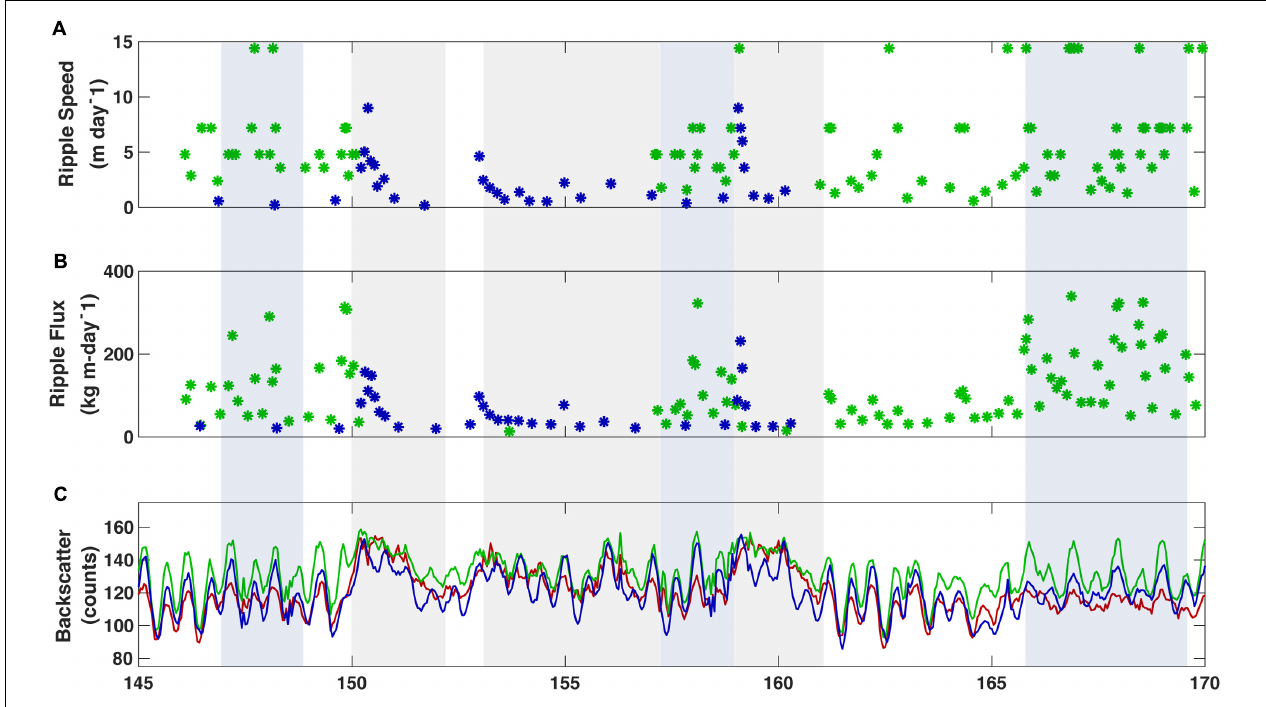
FIGURE 7 | Sediment flux parameters measured at the three sites across the reef flat and lagoon. (A) Bedform migration rate. (B) Total sediment flux by migrating bedform. (C) Near-bed acoustic backscatter from 10 cm above bottom, a proxy for suspended sediment. Color represents the site location: Red = TR1 on the outer reef flat near the reef crest, blue = TR2 on the inner reef flat, and green = TR3 in the